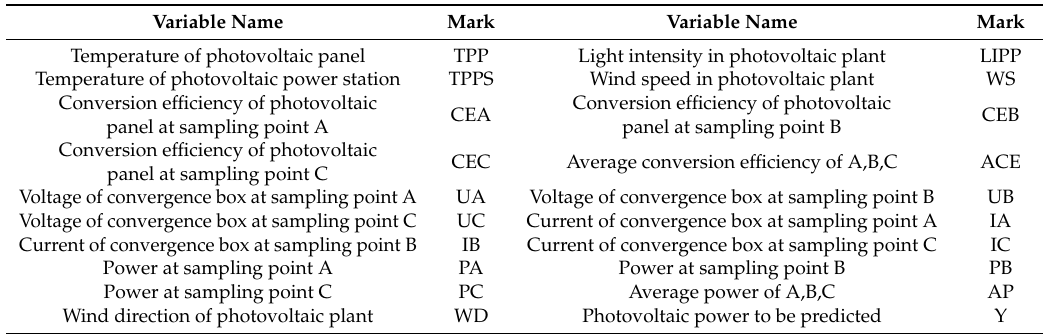
Table 1. Variables and description.